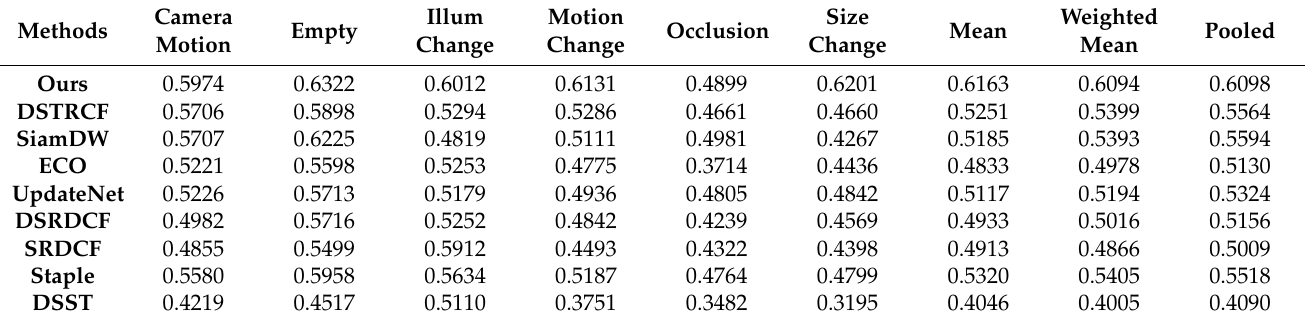
Table 2. Accuracy results among all compared trackers evaluate on VOT2018.